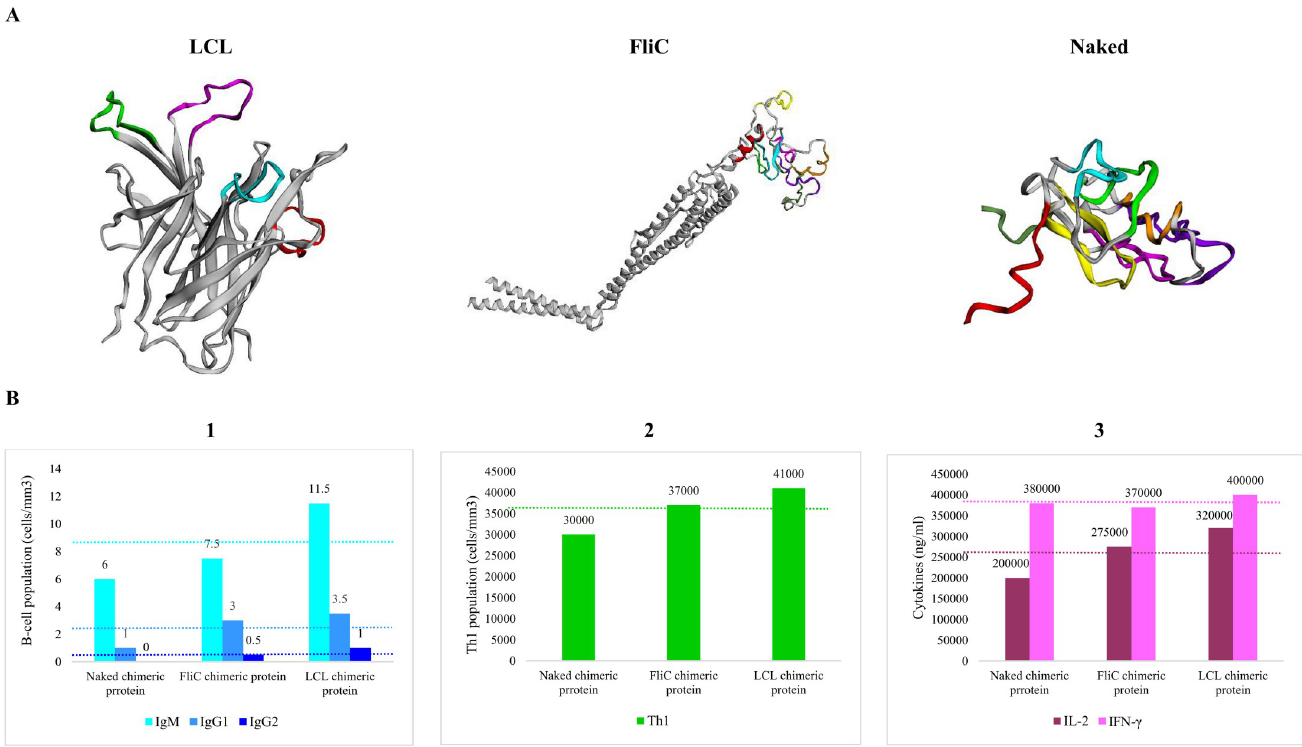
Fig 6. The tertiary structure of multi-epitope vaccines and immune simulation. A) 3D structures of the multi-epitope vaccines were predicted by the Robetta webtool and validated by the ProSA-web server. The linear epitopes are colored using Jmol software. B) The immunoreactivity of multiple epitope-based proteins was predicted by the C-ImmSim web server. 1. The levels of the B-cell population secreting IgM, IgG1 and IgG2. 2. The levels of Th1 populations. 3. The levels of IL- 2 and IFN- γ cytokines. The LCL chimeric protein showed the greatest immunoreactivity.